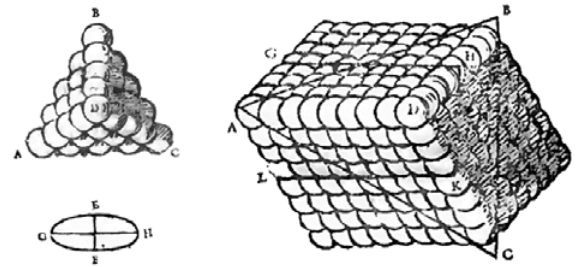
Figure 3. Anisotropic structure model based on close packing of revolution ellipsoids proposed by C. Huygens to explain the bire- fringence of calcite; a bidimensional section through the revolution axis of an ellipsoid is shown. (From reference 6, pp. 92-93).